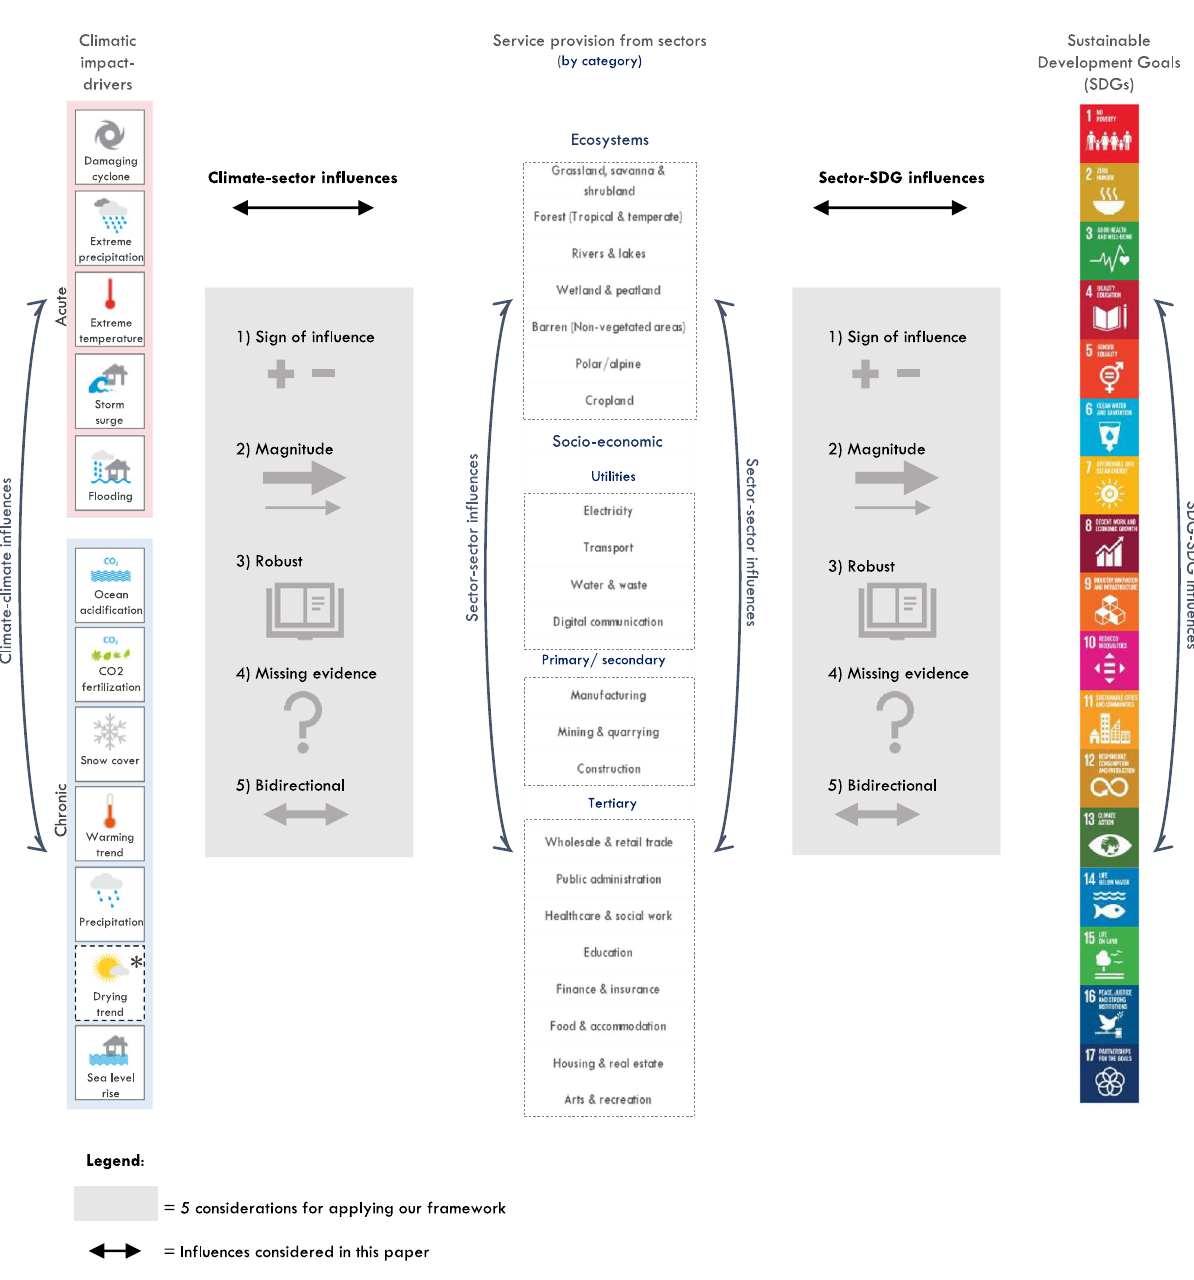
Fig. 6 Five considerations in applying the proposed framework on in fl uences amongst climatic impact-drivers, sectors and the SDG targets. Grey shading illustrates the fi ve considerations. Bold black arrows depict in fl uences considered in this paper, blue light arrows show future in fl uences of climate – climate (compound events), sector – sector (sectoral interdependencies), and SDG – SDG in fl uences (SDG interdependencies) to be considered in the national application of our framework. The aim of the application determines the relative importance of each consideration and whether a climate- fi rst (from climate via sectors to SDG targets) or a development- fi rst (from SDG targets via sectors to climate) approach is adopted. The symbol * denotes the grey boundaries on whether a drying trend and droughts are classi fi ed as chronic or acute climatic